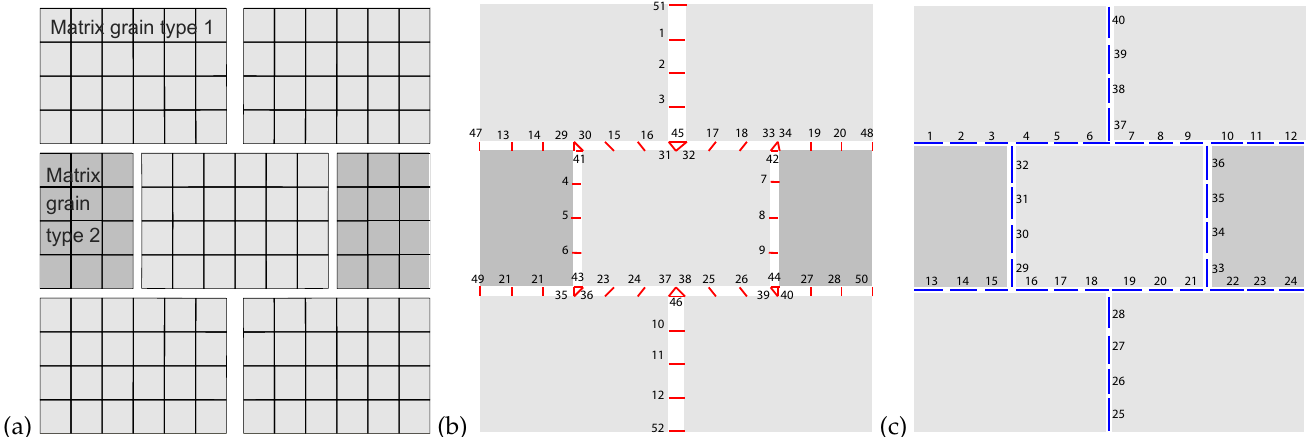
Figure 1. Geometry of the micro-scale Finite Element mesh with two matrix grain types ( a ), crack network nodes or links ( b ) and crack network elements containing two Gauss points each ( c ). Periodic boundary conditions are enforced by penalization, thus increasing the non- zero count in the global stiffness matrix as well as the bandwidth (Figure 2), which in turn increases the computational load of the solver. In order to minimize eigenvector disparity which can cause poor solver performance, penalization stiffness is limited at 10 3 times the stiffness of the undamaged cracks.